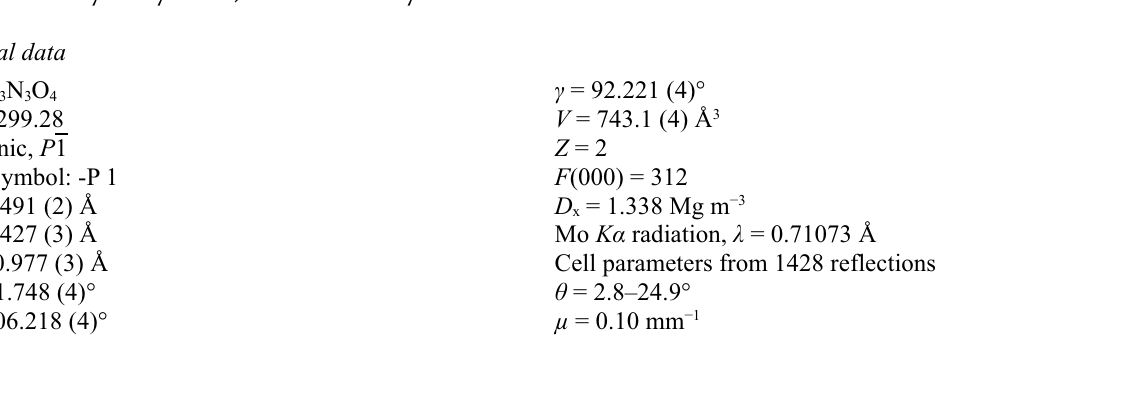
The crystal packing of (I), viewed along the a axis. Dashed lines indicate hydrogen bonds. N ′